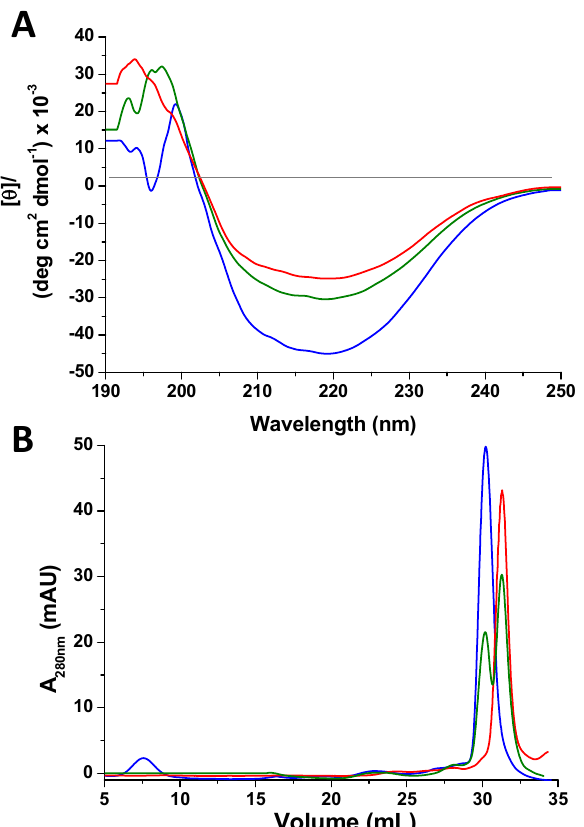
Figure 3. ( A ) Far-UV circular dichroism spectra in 25 mM phosphate bu ff er (pH 7.0) of apo Atox1 in the reduced form (blue) and after 1 h (green) and 12 h (red) incubation with three equivalents of GSSG, plotted as the mean residue molar ellipticity, [ θ ]. ( B ) Analysis by size-exclusion chromatography (SEC) of apo Atox1 in the reduced form (blue) and after 1 h (green) and 12 h (red) incubation with three equivalents of GSSG. The chromatography was carried out on a Superdex 75 Increase 10 / 300 column (GE Healthcare, column volume 24 mL) using 20 mM ammonium acetate (pH 6.5) at a flow rate of 0.5 mL min − 1 . The volume of protein solution injected was 0.5 mL for each run.